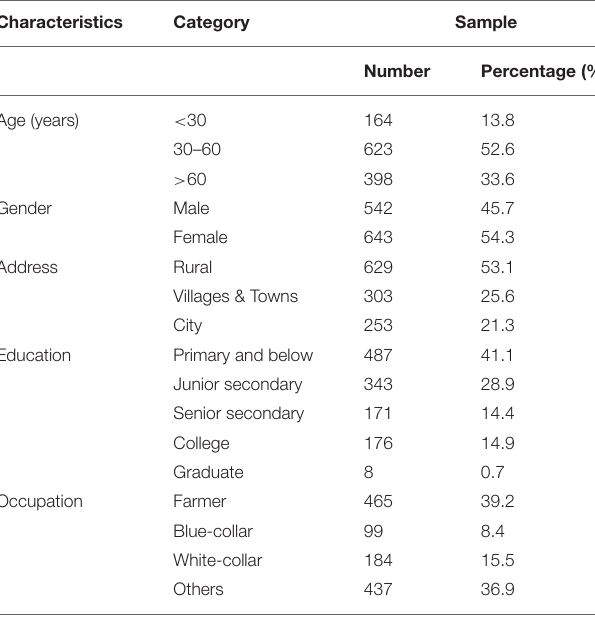
TABLE 2 | Univariate analysis of factors associated with patients’